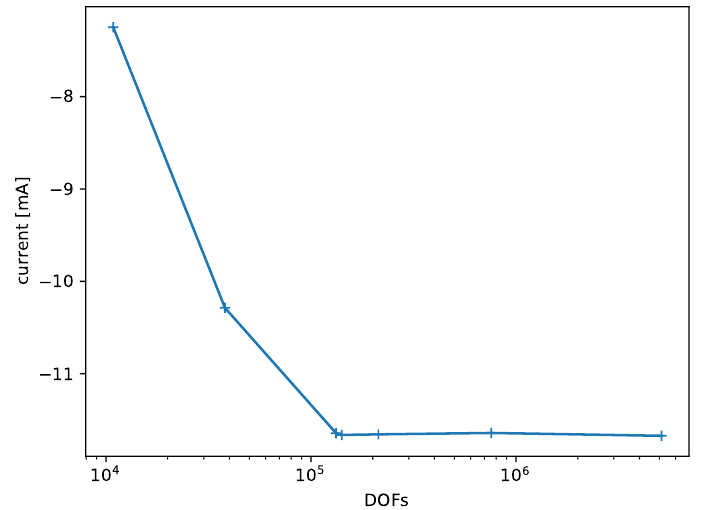
Figure 8. Convergence of the current with respect to the number of degrees of freedom (DOFs). Note that for a large number of DOFs, numerical issues may arise due to the small size of individual